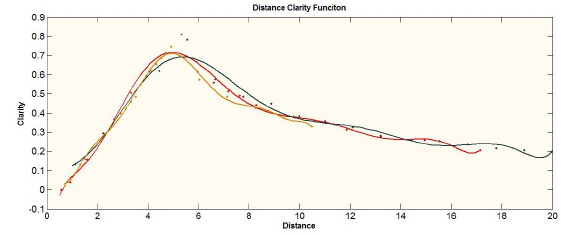
Figure 9. Curve of Distance Clarity function